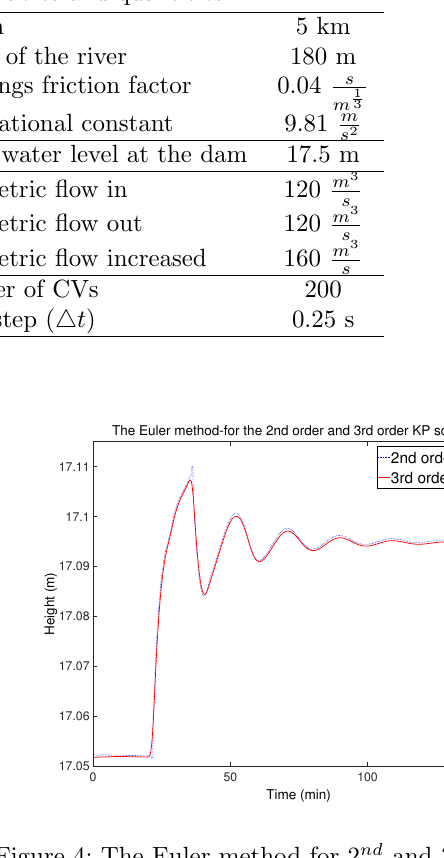
Figure 3: River bottom topography. Figure 4: The Euler method for 2 nd and 3 rd order KP scheme ( (cid:52) t = 0 . 25 s